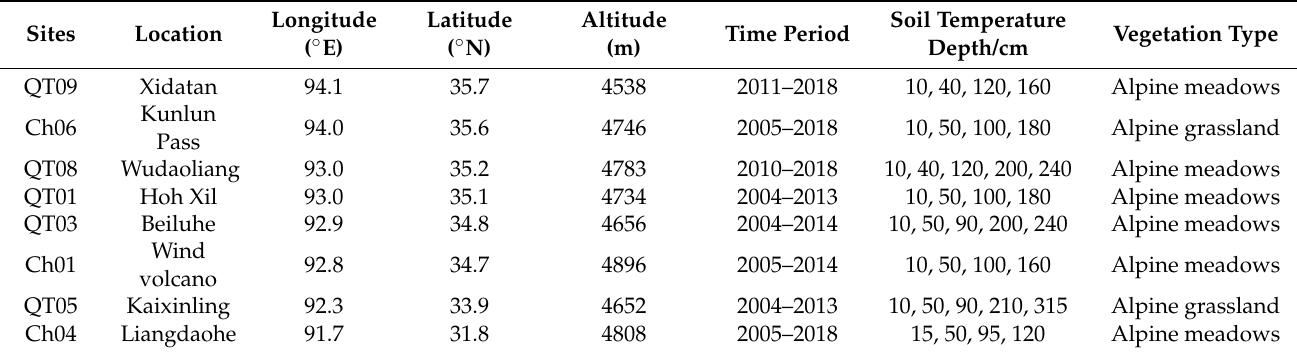
Table 1. Detailed information of monitoring sites.